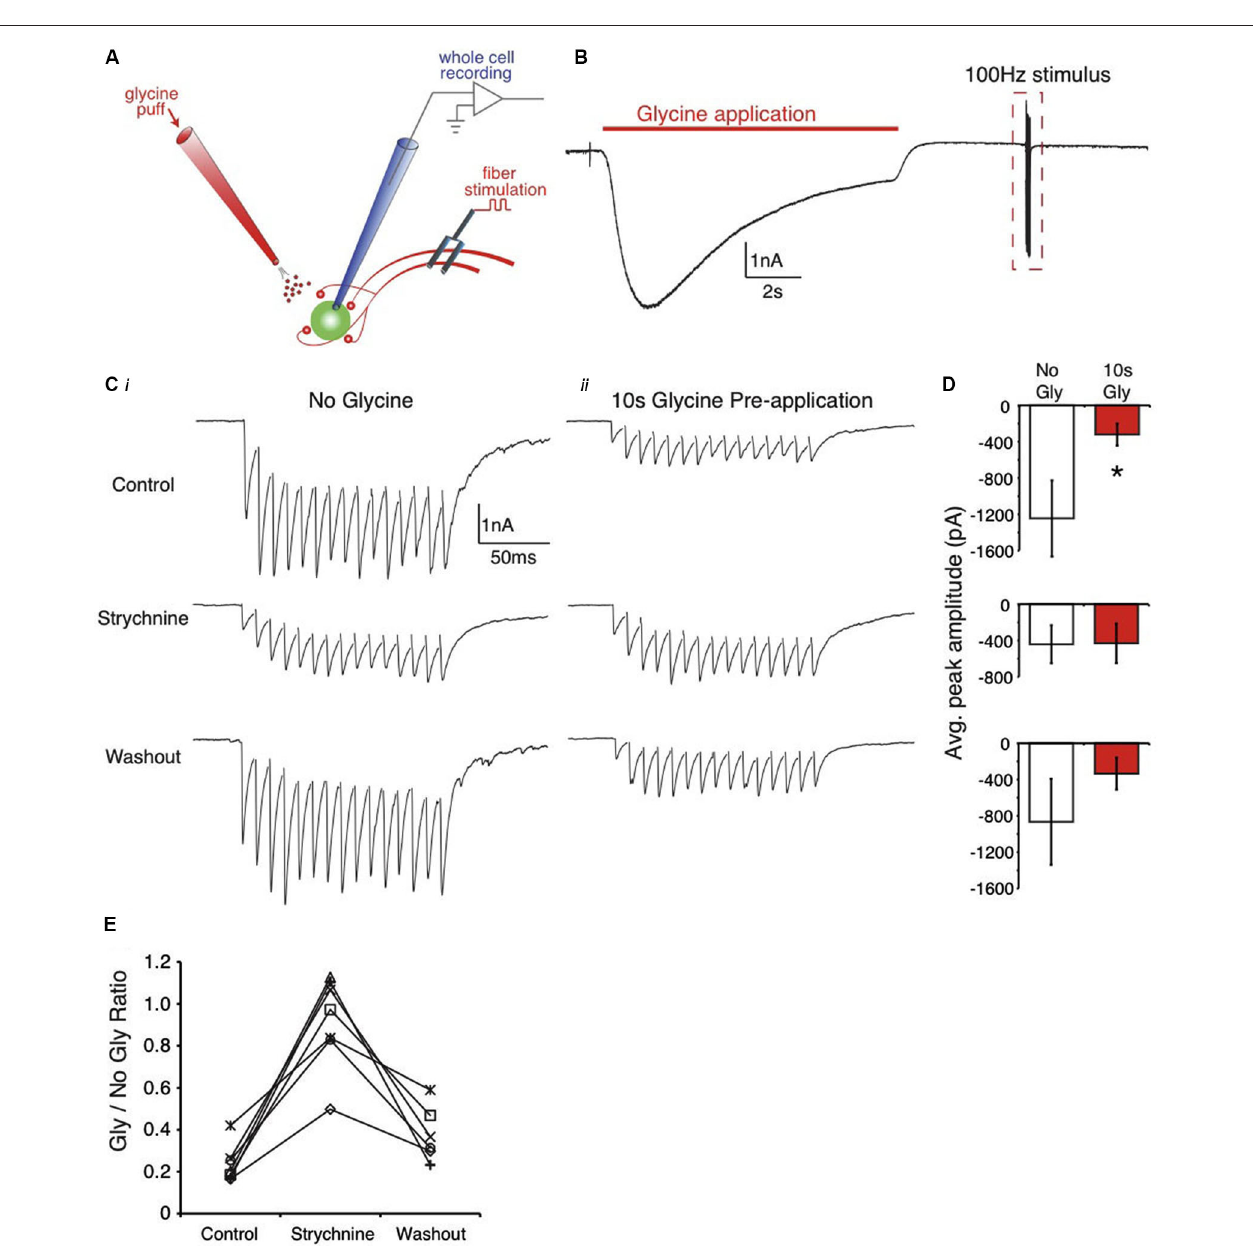
the glycine pre-application show amplitude suppression that is blocked by strychnine. (D) Population data values for the IPSC amplitudes in each condition (* indicates significant difference, p < 0.01). (E) Ratio of evoked amplitudes between glycine pre-application and no glycine in each condition reveals a decrease in the suppression (ratio near 1) in